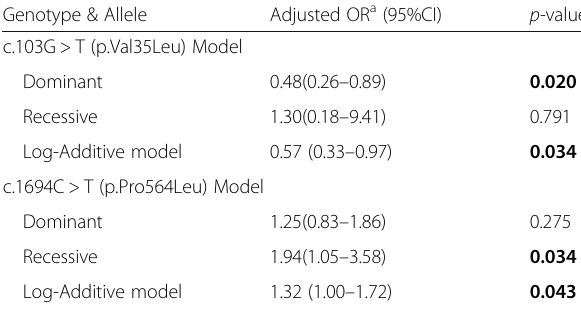
Table 2 Logistic Regression Analysis of association between F13A SNPs and aSAH